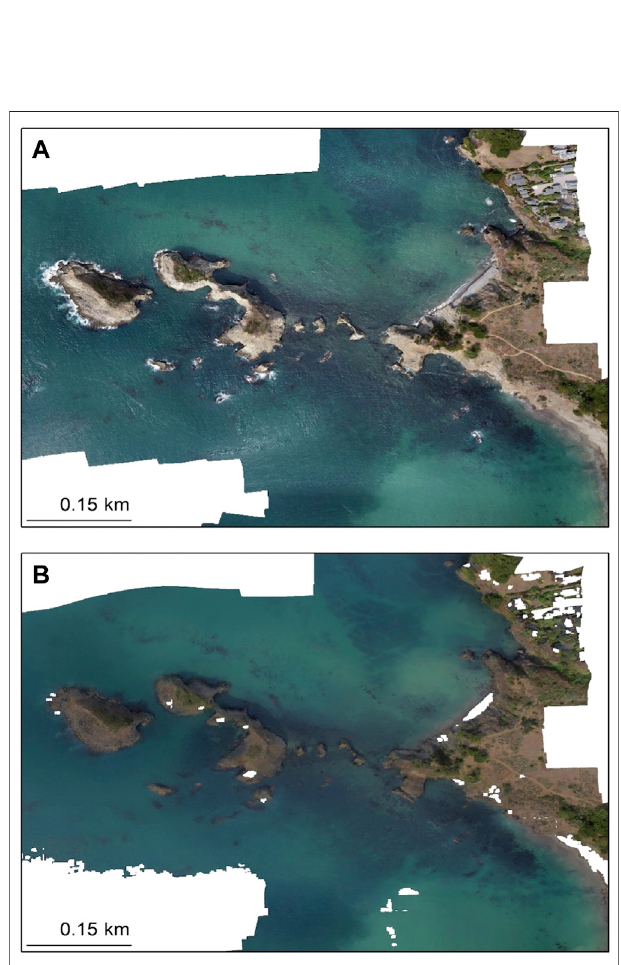
FIGURE 3 | Example of a UAV-based orthomosaic export from Agisoft Metashape Pro without the glint correction applied (A) and with the glint correction applied (B) . Land areas that were erroneously removed with the glint correction are apparent – masks containing coastline can be excluded to reduce this